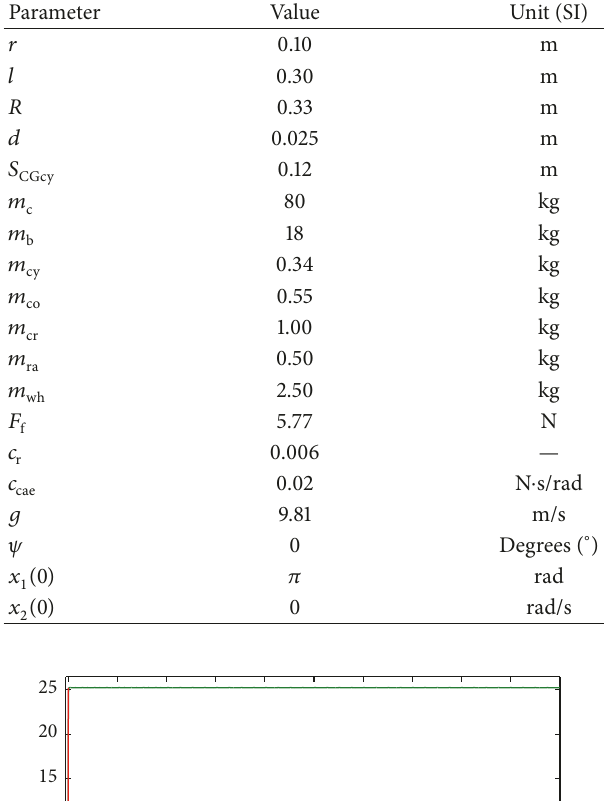
Table 1: Parameters for simulation.